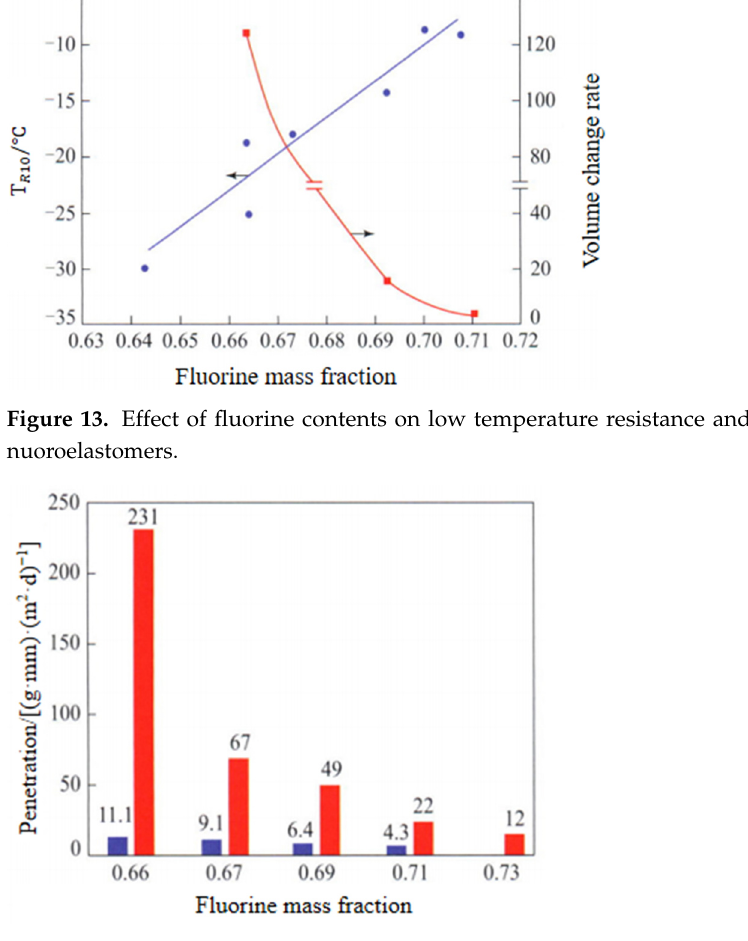
Figure 14. Effect of fluorine contents on fuel permeation rates of fluor elastomers. Blue column: fuel oil C; Red column: CM20 (fuel oil C/methanol is 80/20)